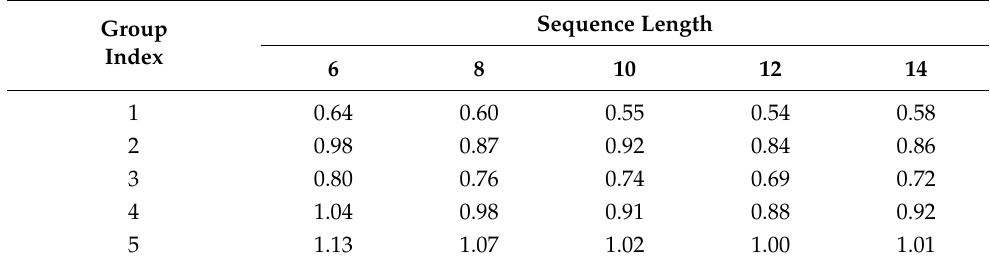
Table 4. RMSE of different input sequence lengths (units: degree).